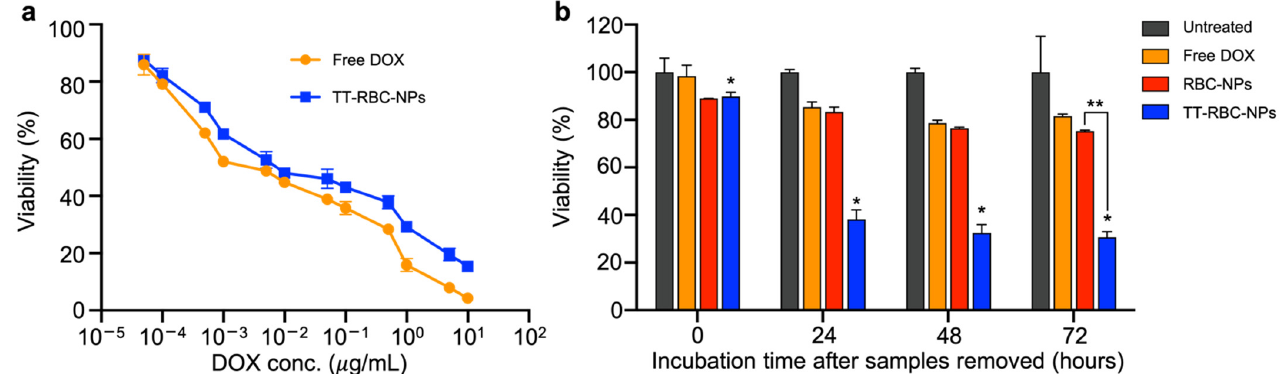
Figure 5. In vitro therapeutic response of TT-RBC-NPs. ( a ) In vitro cytotoxicity of free DOX and TT-RBC-NPs against MCF-7 breast cancer cells after 72 h incubation. ( b ) In vitro efficacy of free DOX, RBC-NPs and TT-RBC-NP (equivalent of 1 µg/mL DOX) against MCF-7 cells. In this assay, samples were incubated for 2 h, and cells were subsequently washed and incubated in fresh medium for additional 0, 24, 48 and 72 h before quantifying toxicity. Data represents mean ± SD ( n = 3). * the significance between TT-RBC-NPs at 0, 24, 48, and 72 h incubation ( p < 0.05). ** the significance between RBC-NPs and TT-RBC-NPs at 72 h incubation ( p < 0.05).